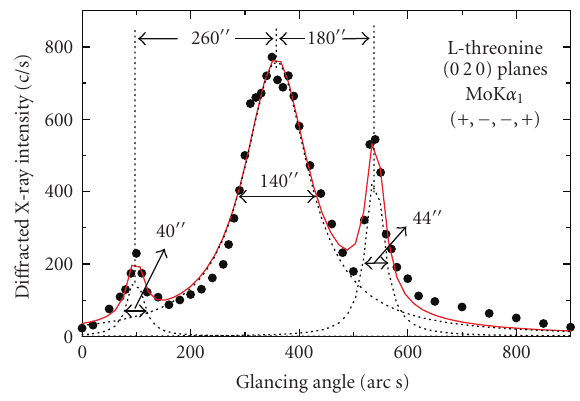
Figure 28: HRXRD curve recorded for L-threonine single crystal grown at pH = 6.70 for (0 2 0) di ff racting planes.